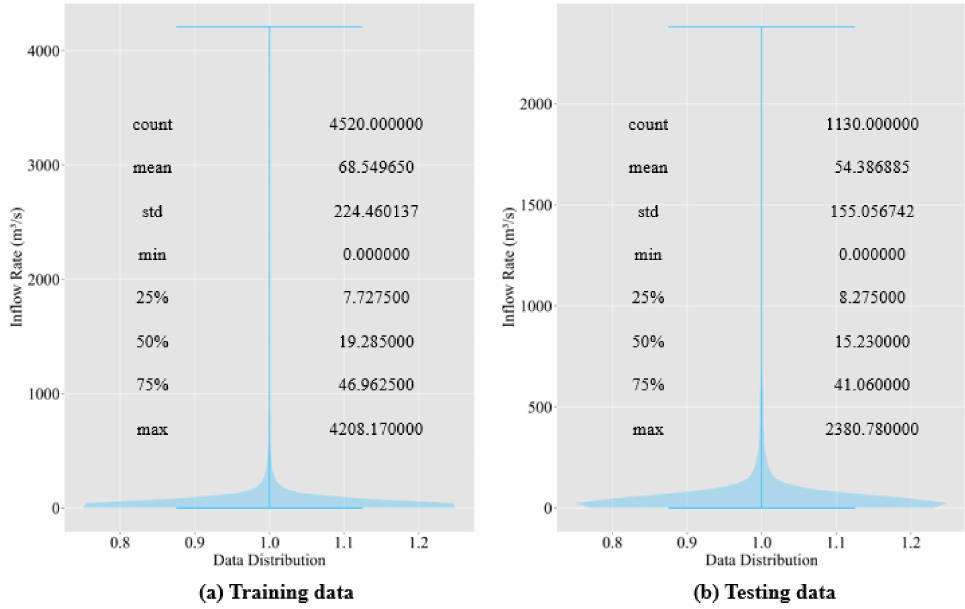
Figure 3. Violin plot for training and testing